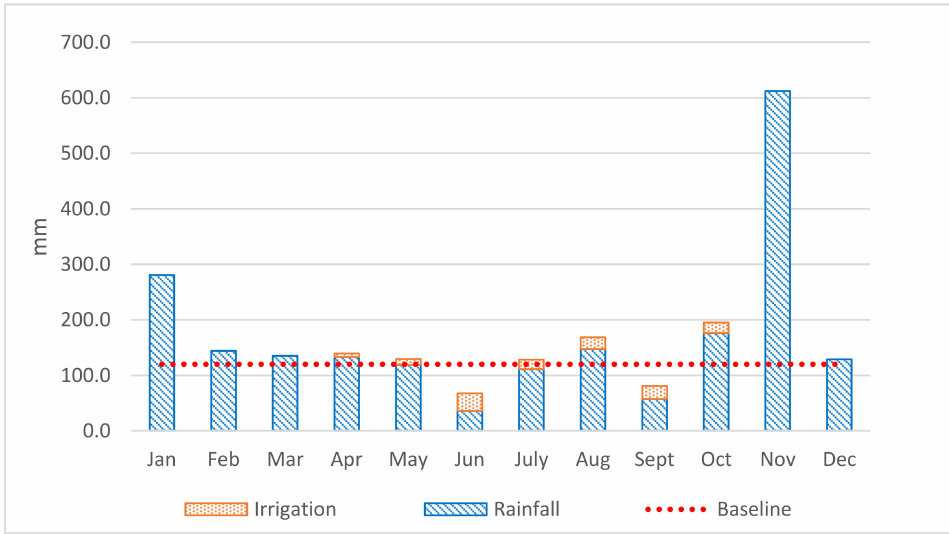
Figure 4. Monthly EID and rainfall distribution for FGVAS Serting Hilir Estate in